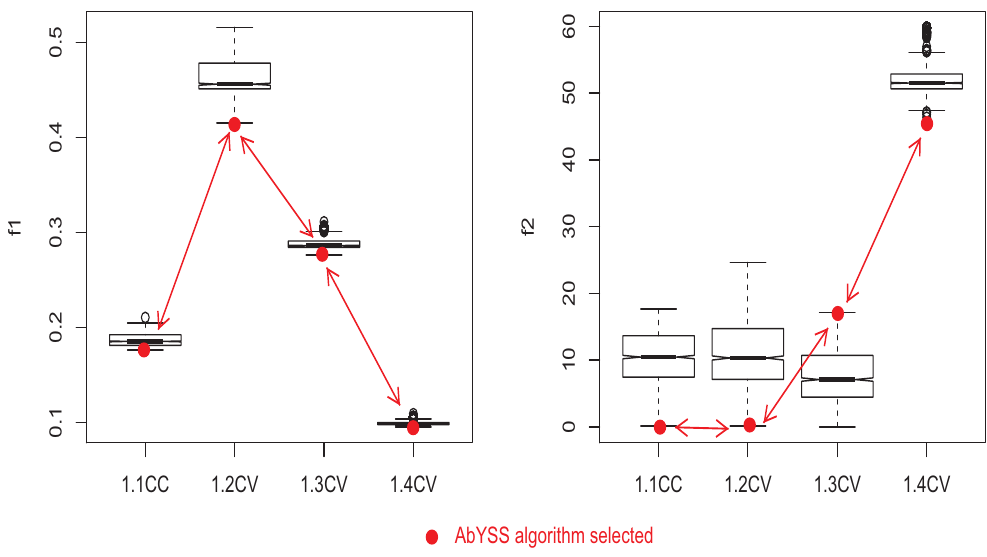
Figure 5. Boxplot diagrams of distributions of objective values obtained by AbYSS, for problem instance 1.1CC (Asua river basin continuous series for calibration). The boxplots of objectives f1 = (1-NSE) and f2 = PBIAs are plotted in the left and right sub-figures,